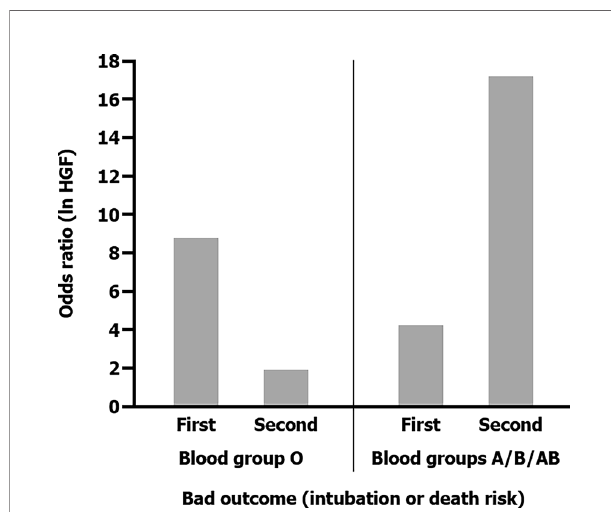
FIGURE 5 | Different odds ratios obtained through four gender- and age- adjusted odd ratio univariable models which associated bad outcome (intubation or death) and HGF levels according to both ABO blood groups and also hospital stay